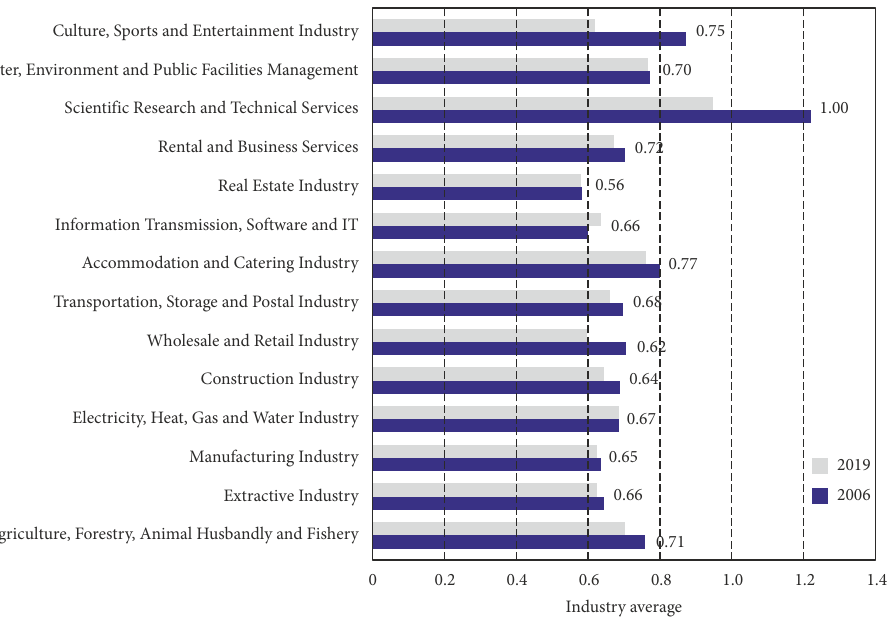
Figure 3. Mean value of corporate strategy deviation by